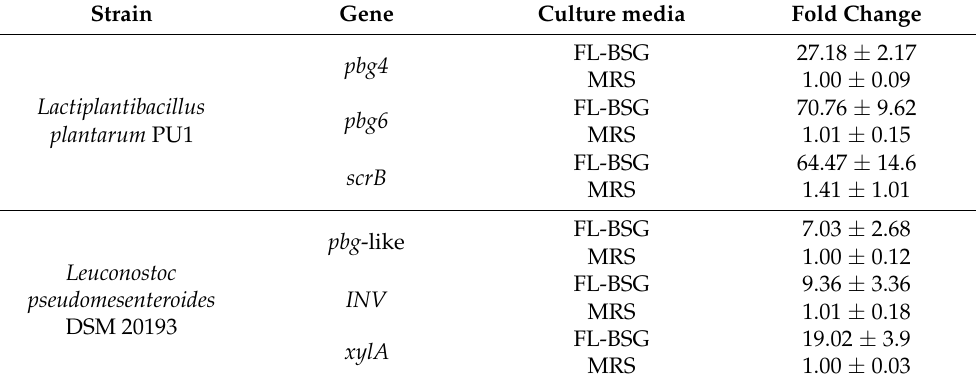
Table 2. Relative expression of selected genes of Leuconostoc pseudomesenteroides DSM 20193 and Lactiplantibacillus plantarum PU1 cultivated on Finnish brewers’ spent grain (FL-BSG) until the late (after ca. 14 h) exponential (LE) phase of growth at 30 ◦ C was reached. The calibrator conditions used were the same bacterial cultures grown in MRS until the LE phase of growth (after ca. 8 h) at 30 ◦ C was reached. Strain Gene Culture media Fold Change FL-BSG 27.18 ± 2.17 pbg4 MRS 1.00 ± 0.09 Lactiplantibacillus FL-BSG 70.76 ± 9.62 pbg6 plantarum PU1 MRS 1.01 ± 0.15 FL-BSG 64.47 ± 14.6 scrB MRS 1.41 ± 1.01 FL-BSG 7.03 ± 2.68 pbg -like MRS 1.00 ± 0.12 Leuconostoc FL-BSG 9.36 ± 3.36 INV pseudomesenteroides MRS 1.01 ± 0.18 DSM 20193 FL-BSG 19.02 ± 3.9 xylA MRS 1.00 ±